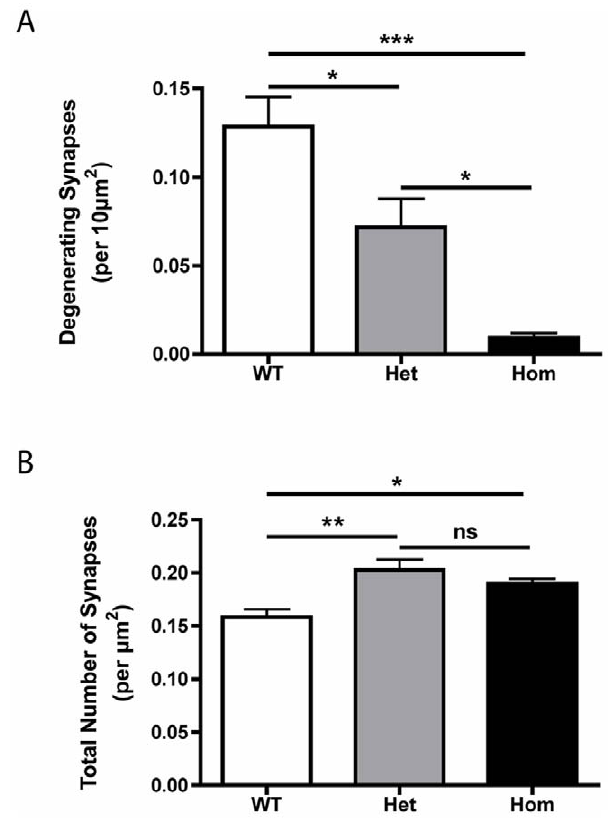
Figure 3. Quantitative analysis of synaptic degeneration confirmed a dose-dependent protection of striatal synapses in Wld S mice 3 days after cortical lesion. A – Bar chart (mean 6 SEM) showing the number of degenerating synapses in the striatum of wild- type (WT), heterozygous Wld S (Het) and homozygous Wld S (Hom) mice 3 days after cortical lesion (***P , 0.001, *P , 0.05, ANOVA with Tukey’s post-hoc test; N=4 wild-type mice, 3 heterozygous Wld S , 3 homozy- gous Wld S ). B – Bar chart showing the total number of synapses remaining in the striatum of wild-type (WT), heterozygous Wld S (Het) and homozygous Wld S (Hom) mice 3 days after cortical lesion (**P , 0.01, *P , 0.05, nsP . 0.05, ANOVA with Tukey’s post-hoc test; N=4 wild-type mice, 3 heterozygous Wld S , 3 homozygous Wld S